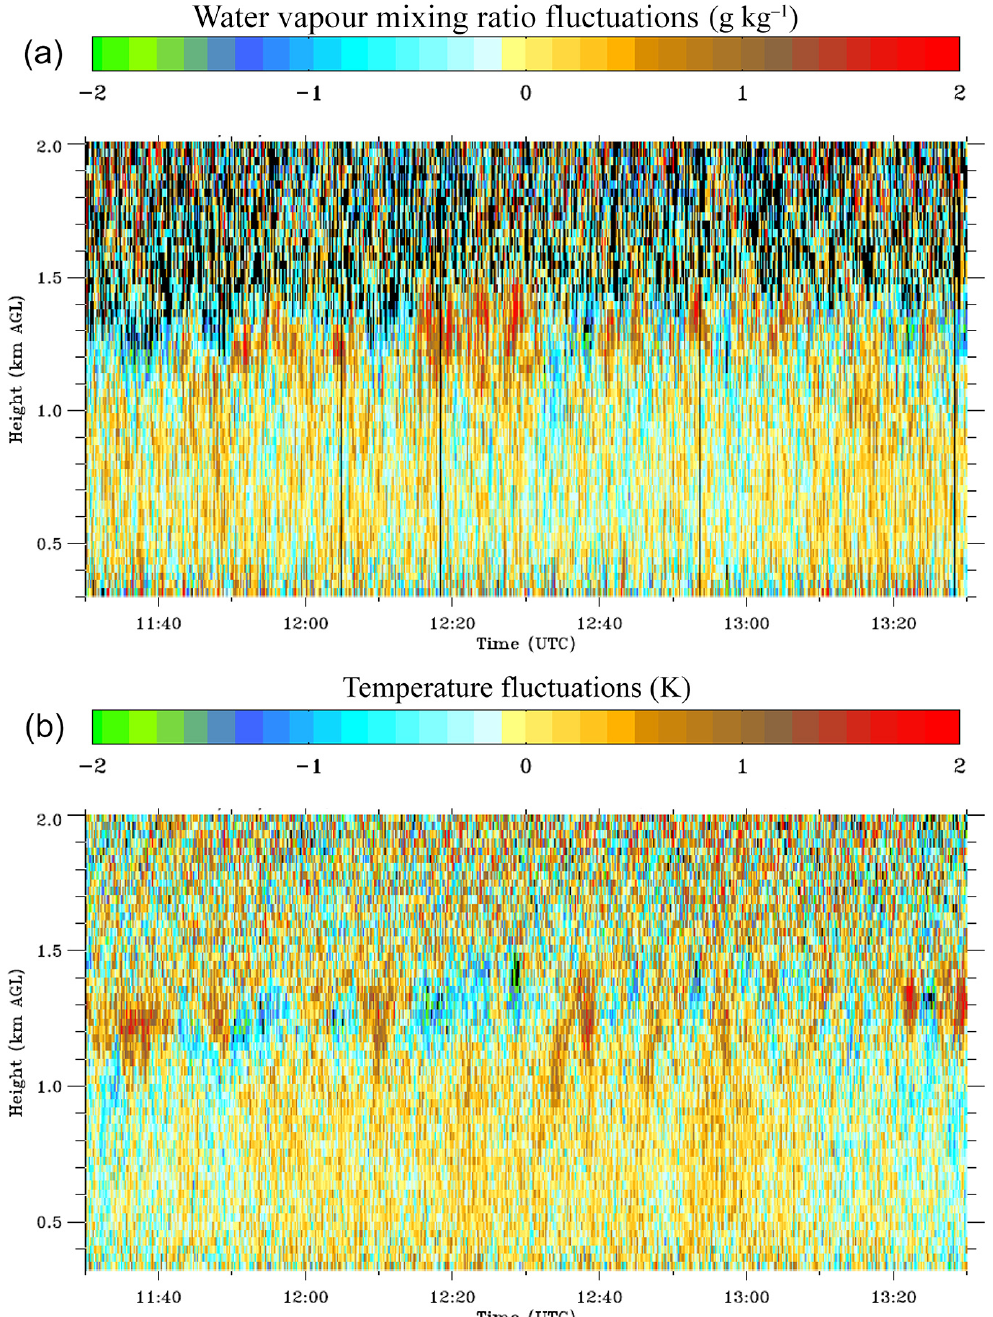
Figure 7. Time–height cross section of water vapour mixing ratio (a) and temperature fluctuations (b) in the same time interval considered in Fig.